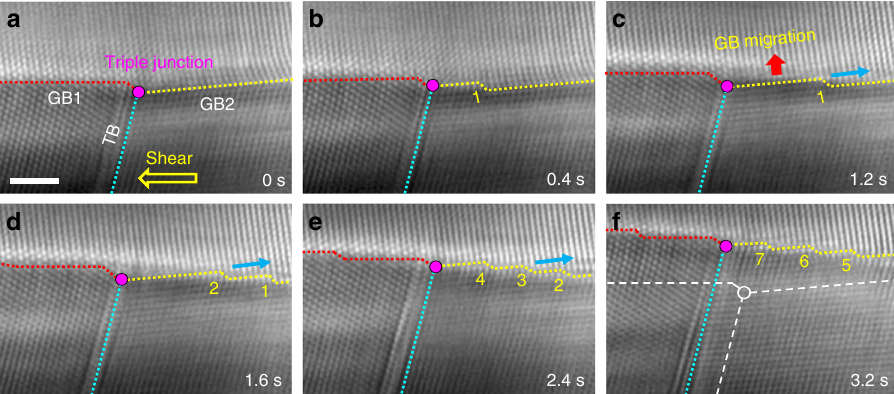
Fig. 6 Nucleation of GB disconnections from the triple junction under shear loading. a High resolution TEM image showing an Au nanostructure with a triple junction (marked out by the purple dot) connecting two general tilt GBs (denoted as GB1 and GB2, respectively) and a twin boundary (TB). A leftward shear stress was applied to the bottom grains, as shown by the yellow arrow. b Nucleation of the fi rst disconnection 1 from the triple junction, which propagated onto the GB2. c Upward migration of the GB2 via the lateral motion of disconnection 1. d Nucleation of disconnection 2 from the GB-TB triple junction. e , f Further upward migration of GB2 induced by the successive nucleation and lateral motion of disconnections. The white dashed lines mark out the initial positions of the GBs and the TB; the blue and red arrows indicate the directions of disconnection motion and GB migration, respectively. Scale bar: 2 nm